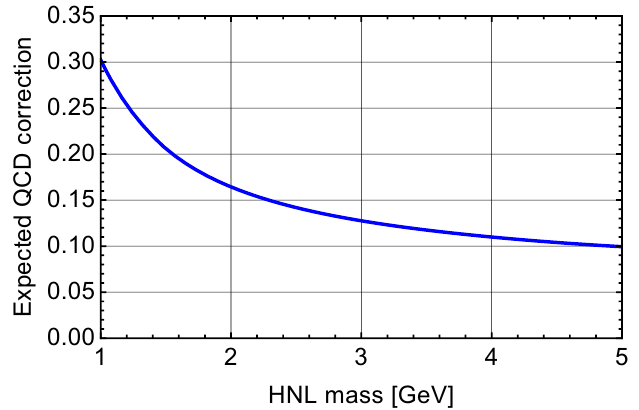
Figure 14 . The estimate of the QCD corrections for the HNL decay into quark pairs, using the three-loop formula (3.11) for (cid:28) -lepton.